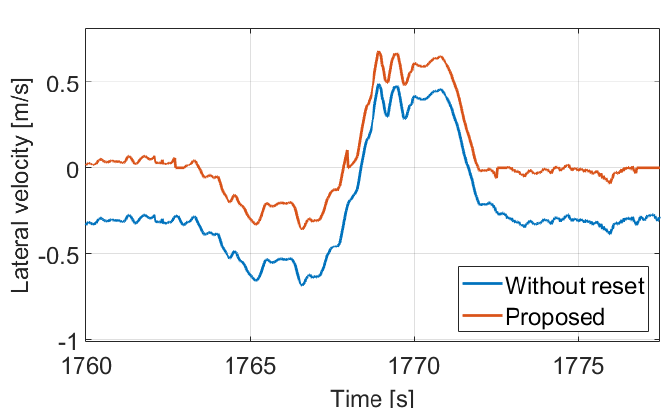
Figure 11. Lateral velocity